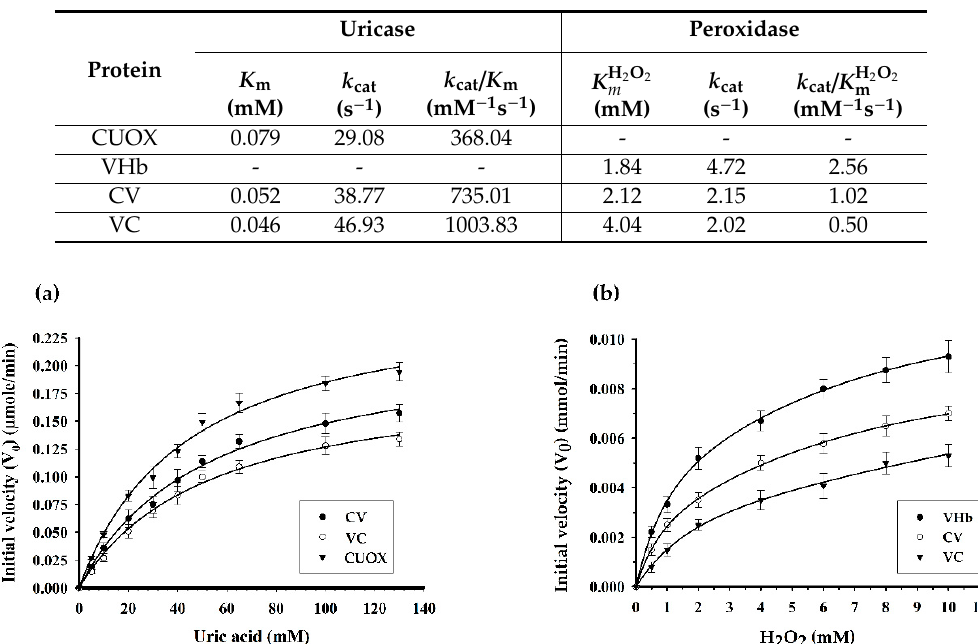
Table 1. Molecular weight, specific and relative activity of the produced proteins. Figure 6. Comparison of uricase activity and peroxidase activity of native and fusion proteins. In the uricase assay ( a ), the rate of substrate oxidation was calculated based on a linear decrease in the absorbance of uric acid. The plots show the dependence of the initial rate of oxidation on uric acid concentration. Whereas in peroxidase assay ( b ), the rate of substrate oxidation was calculated based on a linear increase in the absorbance of resorufin. The plots show the dependence of the initial rate of oxidation on hydrogen peroxide concentration. All plots were fitted to the Michaelis-Menten equation.